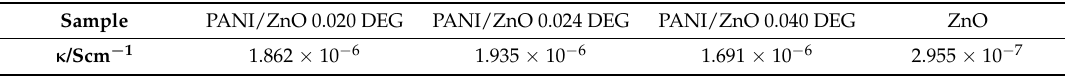
Table 2. Conductivity ( κ ) of PANI/ZnO composites and pure